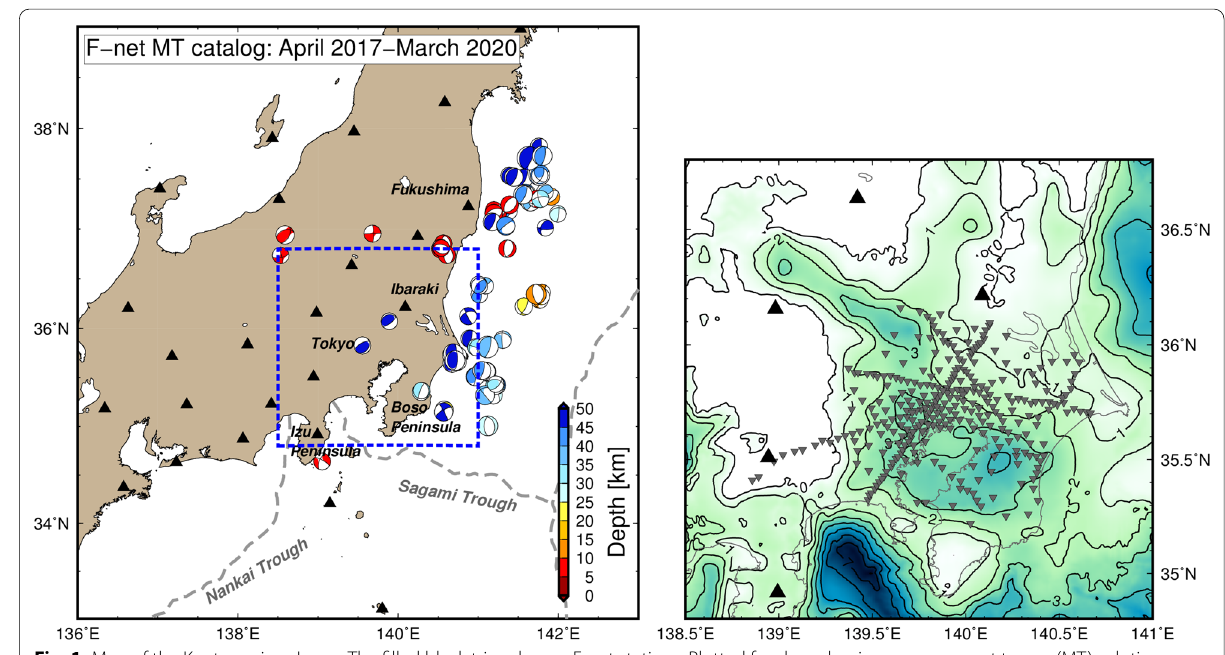
Fig. 1 Map of the Kanto region, Japan. The filled black triangles are F-net stations. Plotted focal mechanisms are moment tensor (MT) solutions listed in the F-net MT catalog. The left panel is an enlarged map of the area and enclosed by the blue dashed line. Inverse triangles in the left panel are MeSO-net stations. The background contours in the right panel is the bedrock depths of the JIVSM (Koketsu et al.